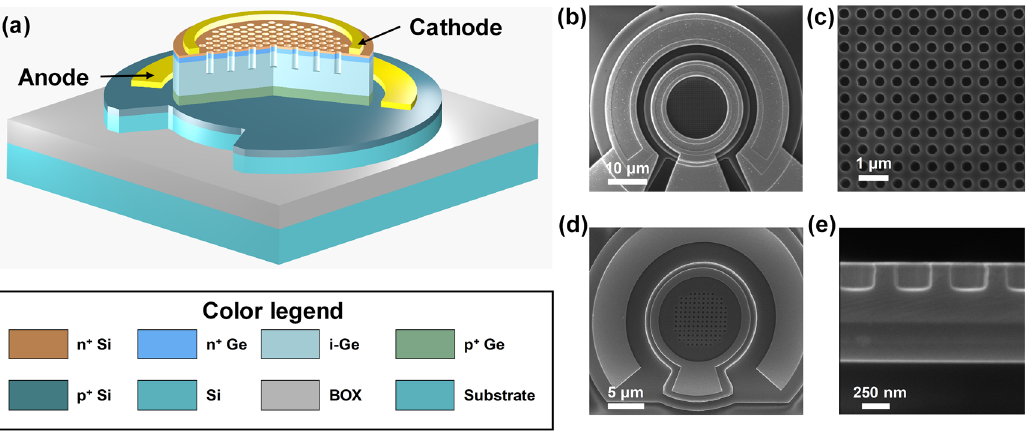
Figure 1: Germanium photodetector enabled by resonant-PhC. (a) Schematic of the resonant-PhC germanium photodetector with an ultrathin absorbing layer (absence of the top SiO 2 layer for clear depiction). Materials of different layers from top to bottom: n + – Si layer, n + – Ge layer, i – Ge layer, p + – Ge layer, p + – Si layer, top Si layer of SOI, BOXofSOI,Si substrateofSOI. (b)Scanning-electron-microscope(SEM)imageof a30- μ m-diameterGe PD withPhC.(c) Enlargedimageof the resonant PhC integrated in the photodetectors. (d) SEM image of a 14- μ m-diameter Ge PD with PhC. (e) Cross section of the resonant PhC etched into the i – Ge layer of the photodetector.